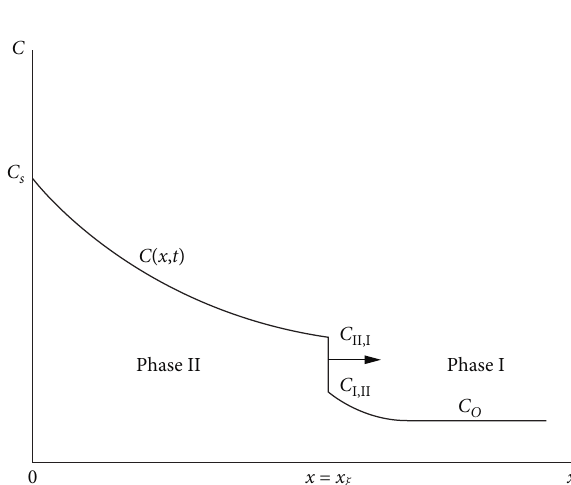
Figure 3: Coordinate for two-phase solid-state